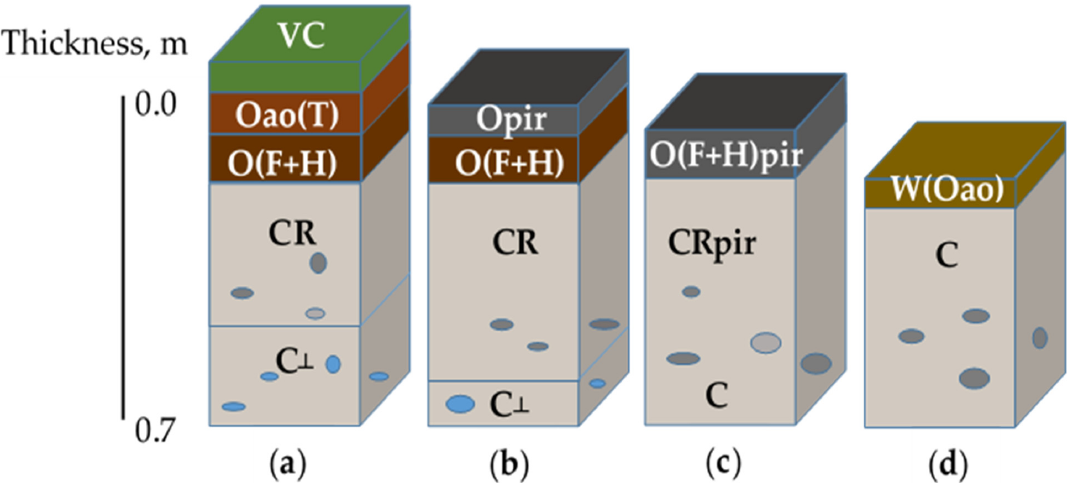
Figure 1. Models of soil profiles of non-disturbed cryozems ( a ), post-pyrogenic cryozems ( b , c ), and technogenic soils ( d ), which are typical for the study area in the permafrost zone of Siberia with marks of peat (T) and cryoturbated (CR) horizons, permafrost level (C ┴ ), postfire litter O(F+H)pir and mineral horizon (CRpir), coarse humus horizon (Oao), vegetation cover (VC), and underdeveloped organic horizon (W).